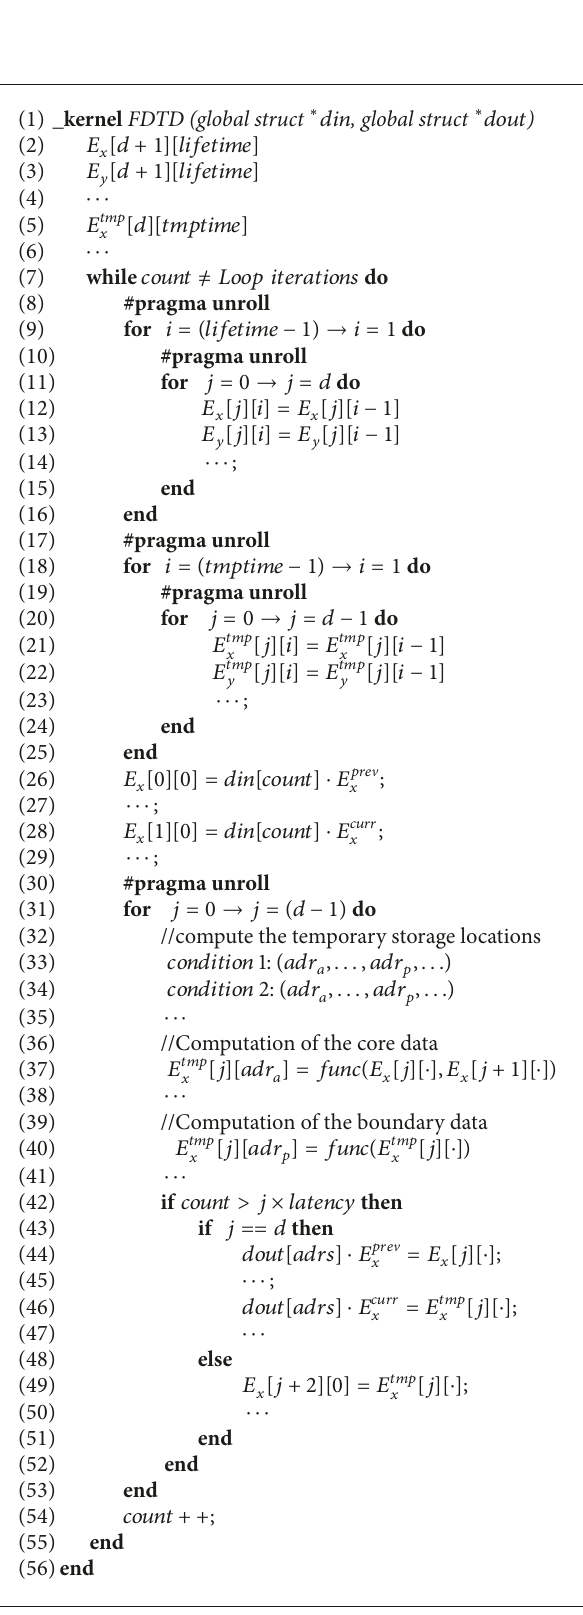
Algorithm 1: Pseudo code of the stencil computation